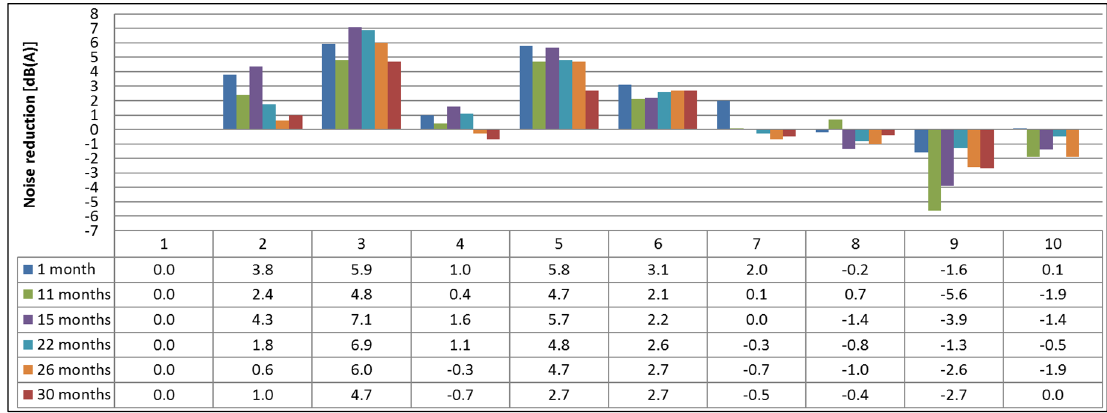
Figure 4. Overview of the noise reduction, based on the SPB results with temperature correction, 1, 11, 15, 22, 26 and 30 months after construction compared to the SMA-10 as a reference road surface at the same time interval.